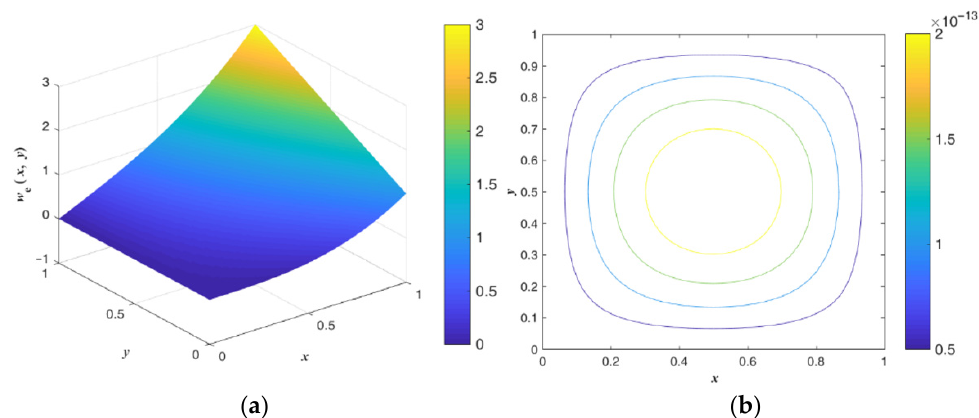
Figure 8. Potential distributions for a linear Poisson problem: ( a ) exact solution; ( b ) absolute er- rors.